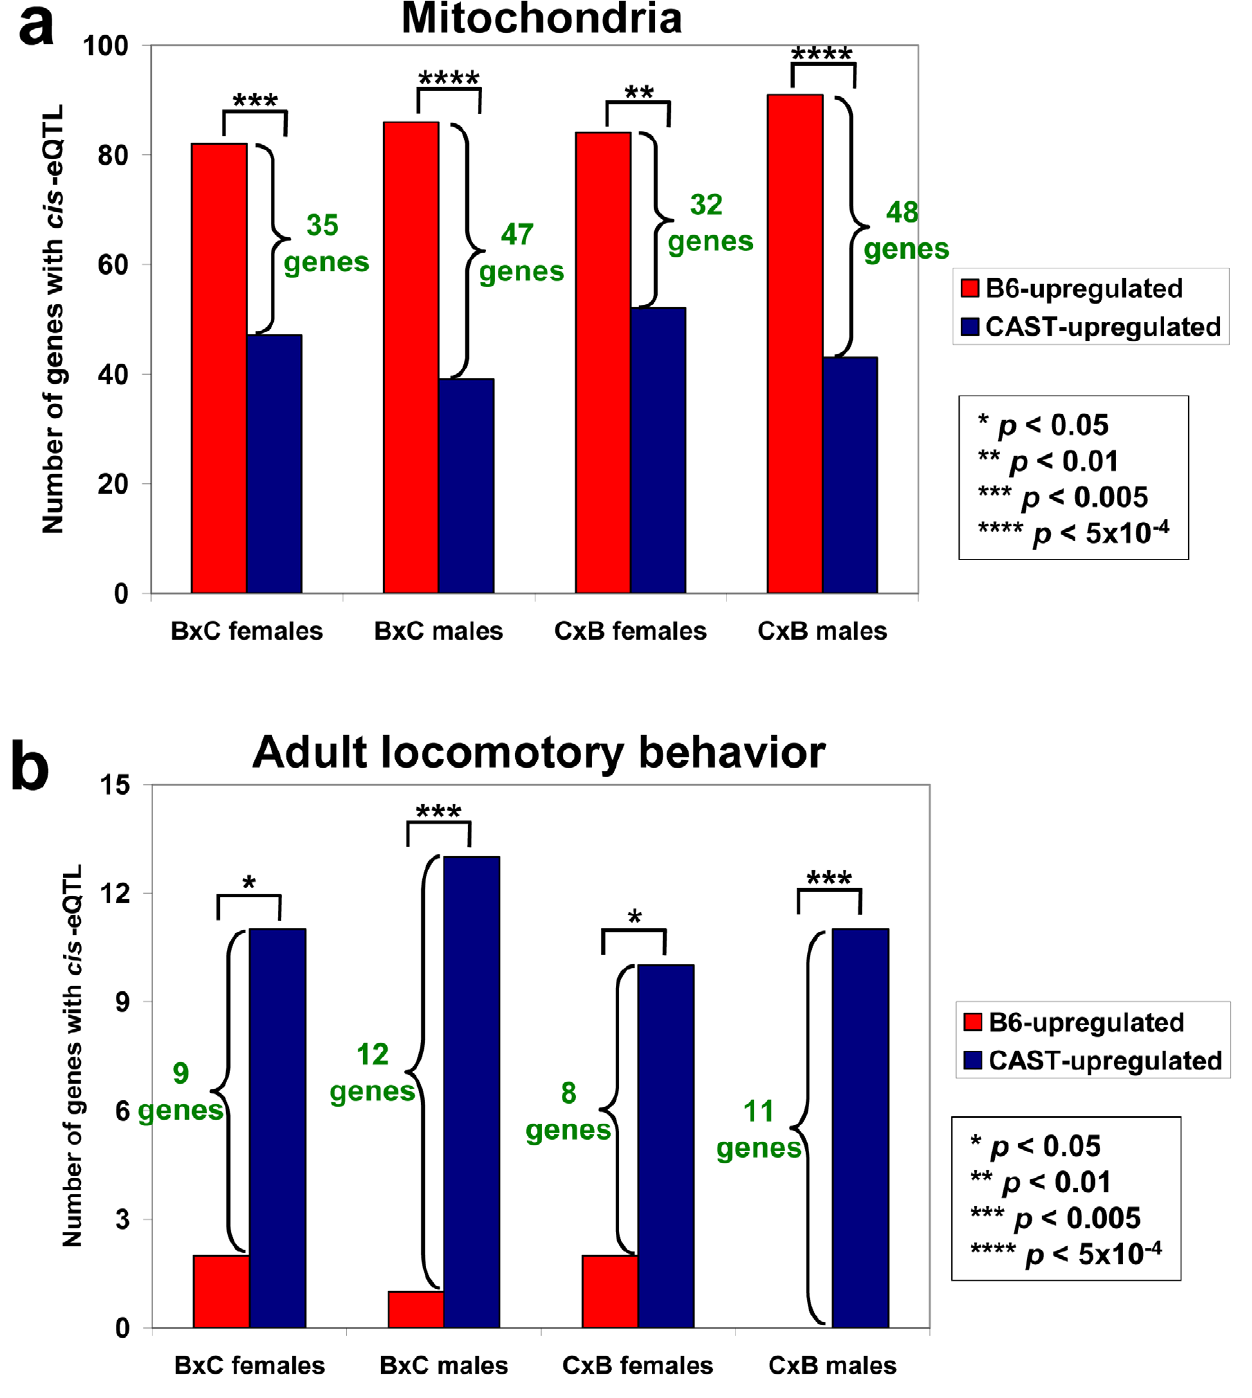
Figure 2. Results of the selection test for two gene sets. (a) Effect directions for cis- eQTLs of mitochondria-related genes in liver. A consistent bias is seen for the B6 alleles to upregulate expression. A lower-bound estimate for the number of genes with cis- regulation under lineage-specific selection is the difference in height between the two bars (numbers in green). (b) Effect directions for cis- eQTLs of adult locomotory behavior-related genes in liver. A consistent bias is seen for the CAST alleles to upregulate expression. This does not imply that the expression changes in liver are relevant for this trait, as the effect is seen in all three tissues, and thus is not tissue-specific.